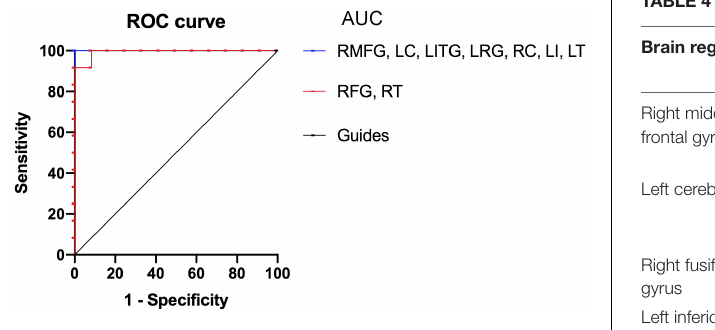
FIGURE 5 | Receiver operating characteristic curve analysis of the mean ReHo values for altered brain regions. The areas under the ROC curve were 1.000 ( P < 0.001; 95% CI: 1.000–1.000) for the RMFG, LC, LITG, LRG, RC, LI, LT; 0.993 ( P < 0.001; 95% CI: 0.971–1.000) for the RFG, RT (SMs < HCs). HCs, healthy controls; SM, severe obesity and meibomian gland dysfunction; ReHo, regional homogeneity; ROC, receiver operating characteristic; AUC, area under curve; RMFG, right middle frontal gyrus; LC, left cerebellum; RFG, right fusiform gyrus; LITG, left inferior temporal gyrus; LRC, left rectus gyrus; RT, right thalamus; RC, right caudate; LI, left insula; LT, left thalamus.